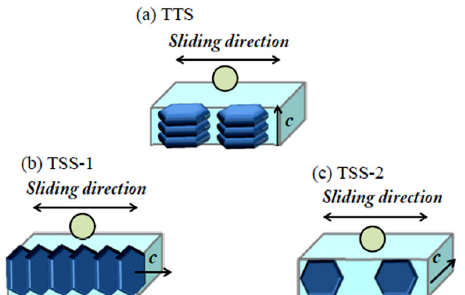
Fig. 1 Schematic figures of wear test along the different texture directions: (a) on the textured top surface (TTS), (b) on the textured side surface (parallel to c axis) (TSS-1), and (c) on the textured side surface (perpendicular to c axis)